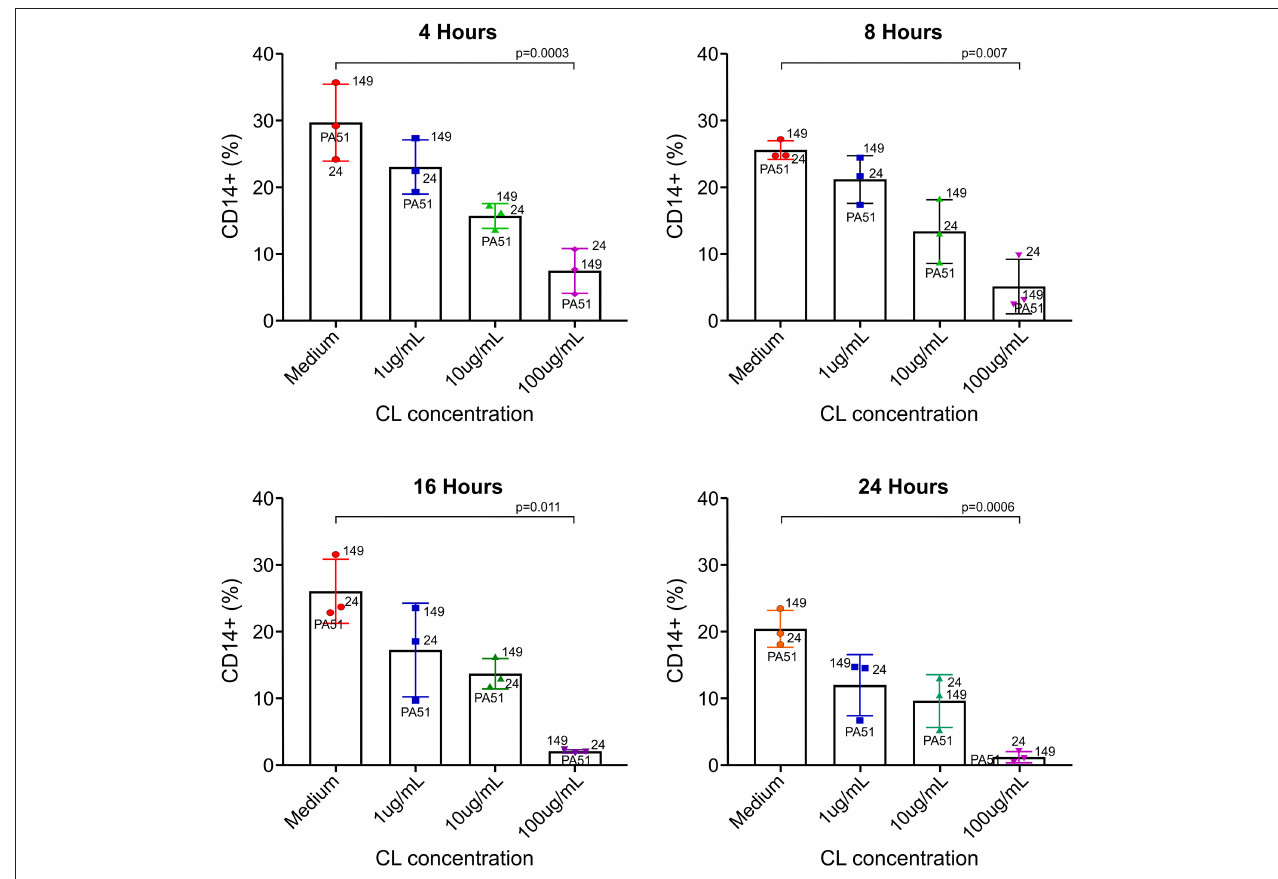
FIGURE 1 | Effect of CL on S. sciureus splenocyte viability in vitro . CL induced dose-dependent cytotoxicity in monocytes/macrophages. 24, 149, and PA51 refer to S. sciureus identification. Medium vs. 100 µ g/ml: 4 h ( p = 0.0003), 8 h ( p = 0.007), 16 h ( p = 0.011), and 24 h ( p = 0.0006). %: percentage of CD14 + cells in total number of